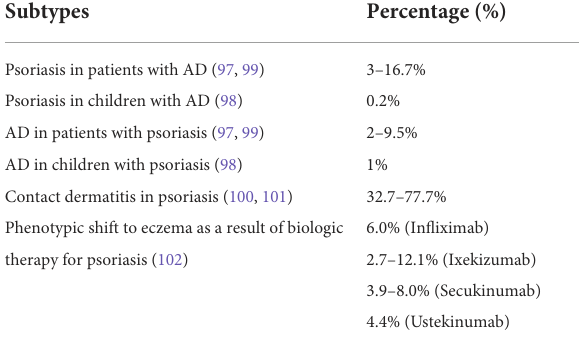
TABLE 1 The distribution of subtypes of Psoriasis and AD in the published articles.